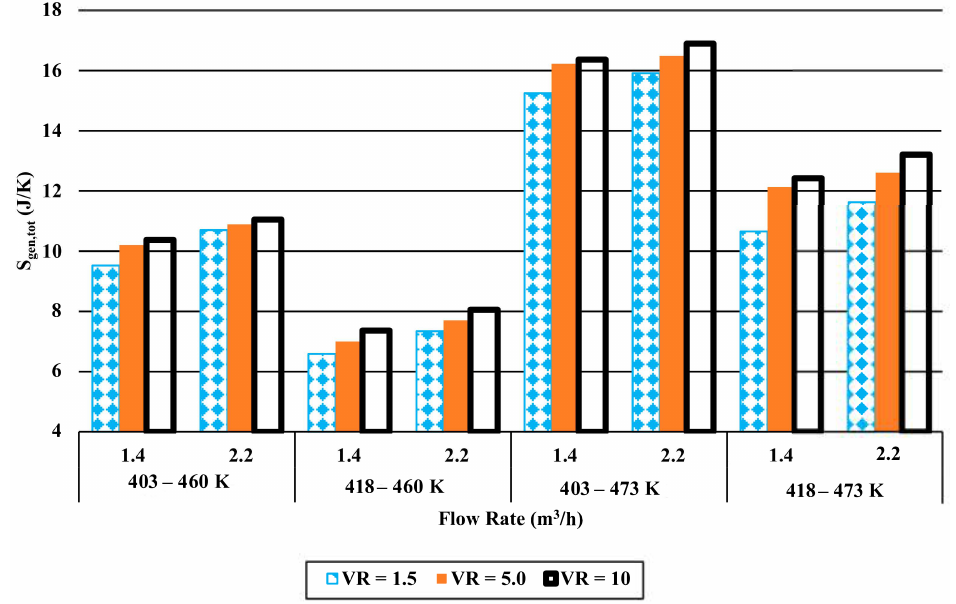
Figure 14. Entropy generation comparison between the existing model and the proposed